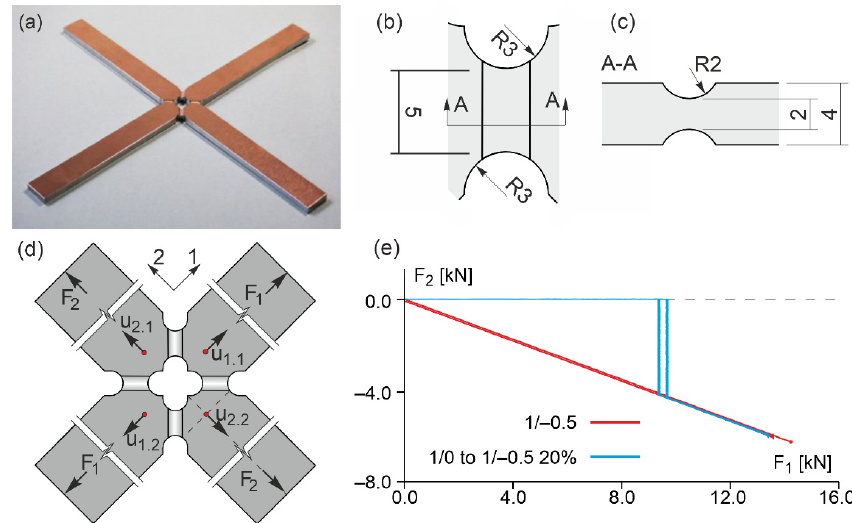
Figure 2. X0-specimen (dimensions in mm): ( a ) photo, ( b ) notch detail, ( c ) notch cross section, ( d ) definition of forces and displacements, ( e ) investigated loading path.